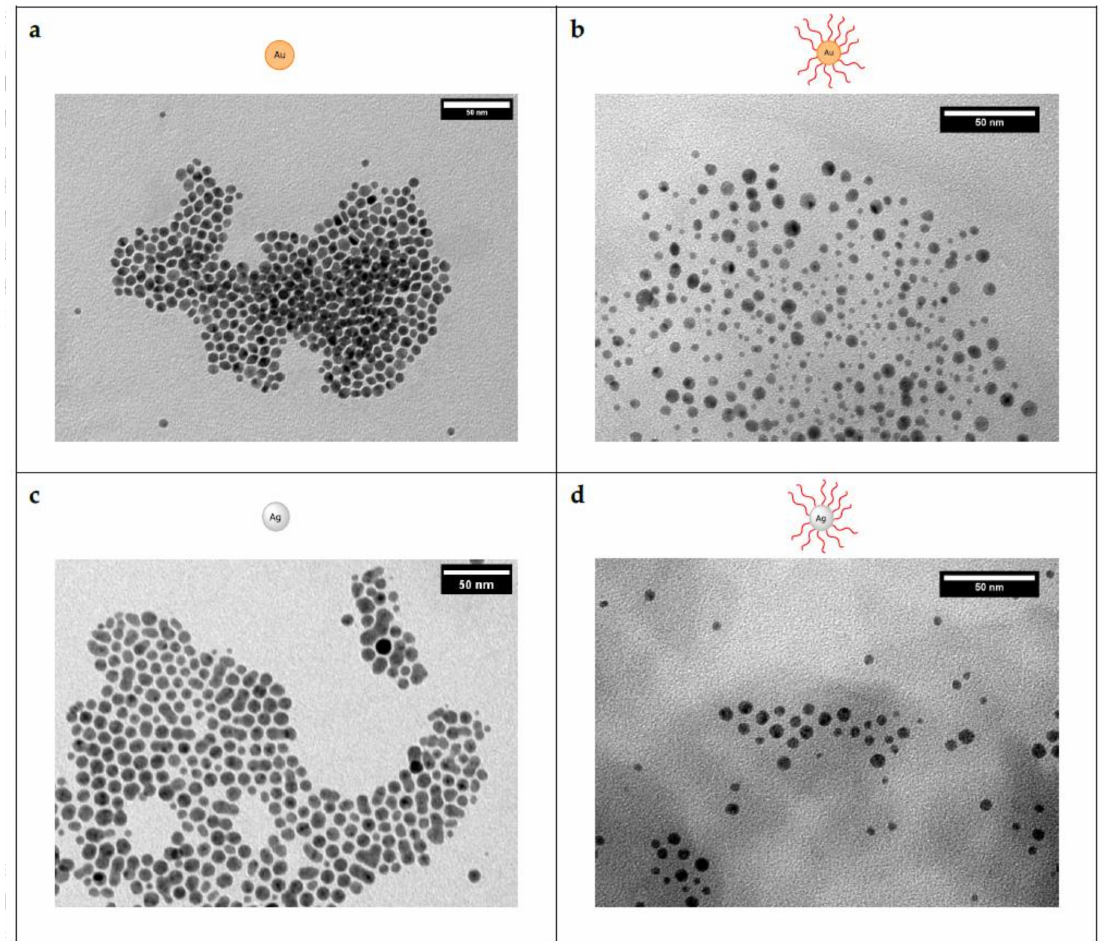
Figure 2. TE micrographs of unfunctionalized ( a , c ) and polyethylene grafted ( b , d ) gold and silver nanoparticles, respectively, showing an increase in interparticle